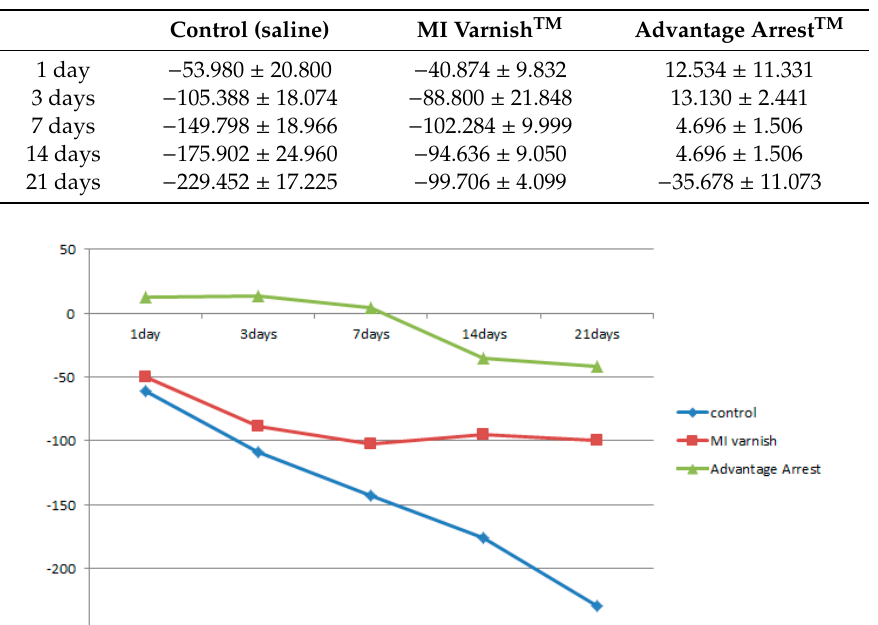
Table 3. Mean ± standard deviation of the change in enamel surface Hounsfield unit value after several treatment durations with the three tested materials.